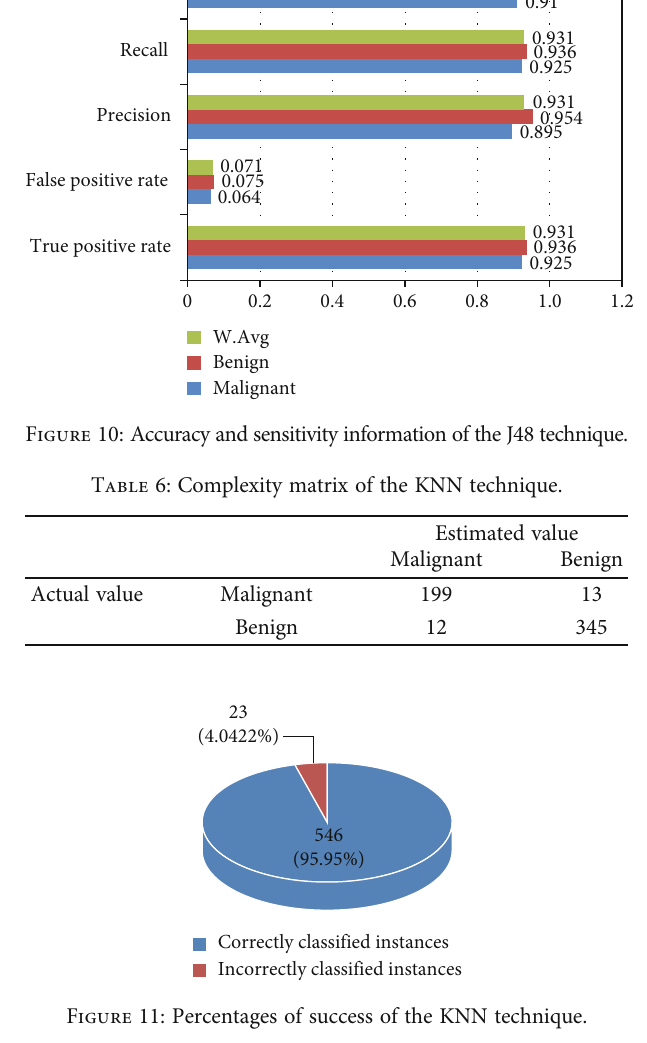
Figure 9: Success percentages of the J48 technique.